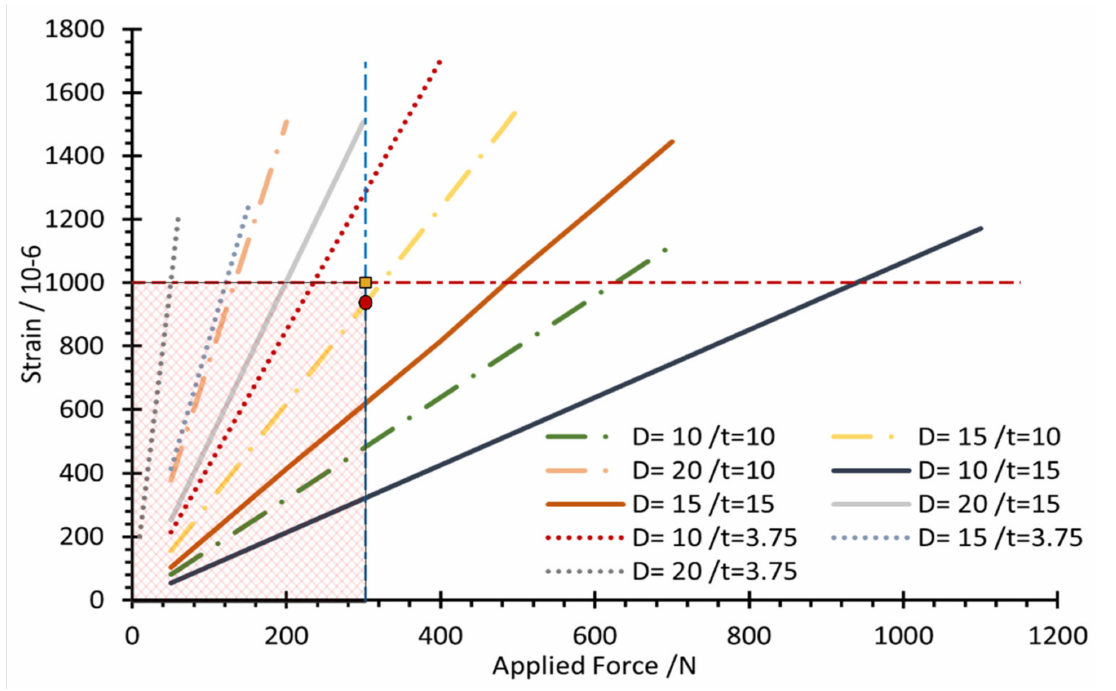
Figure 12. Limiting factors for the design parameters.